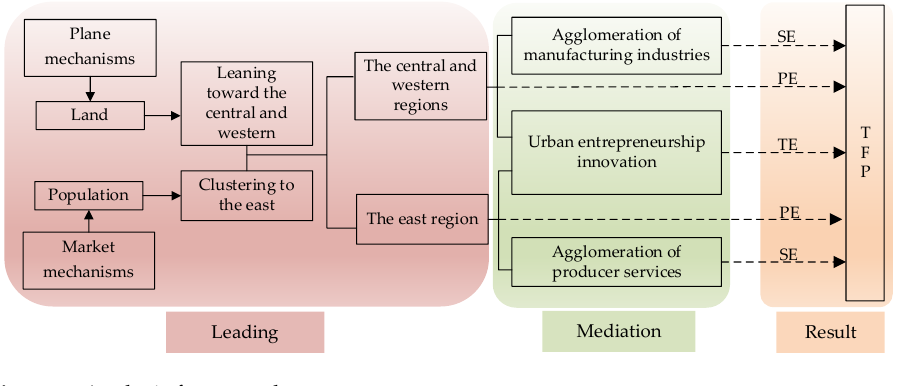
Figure 3. Analysis framework.